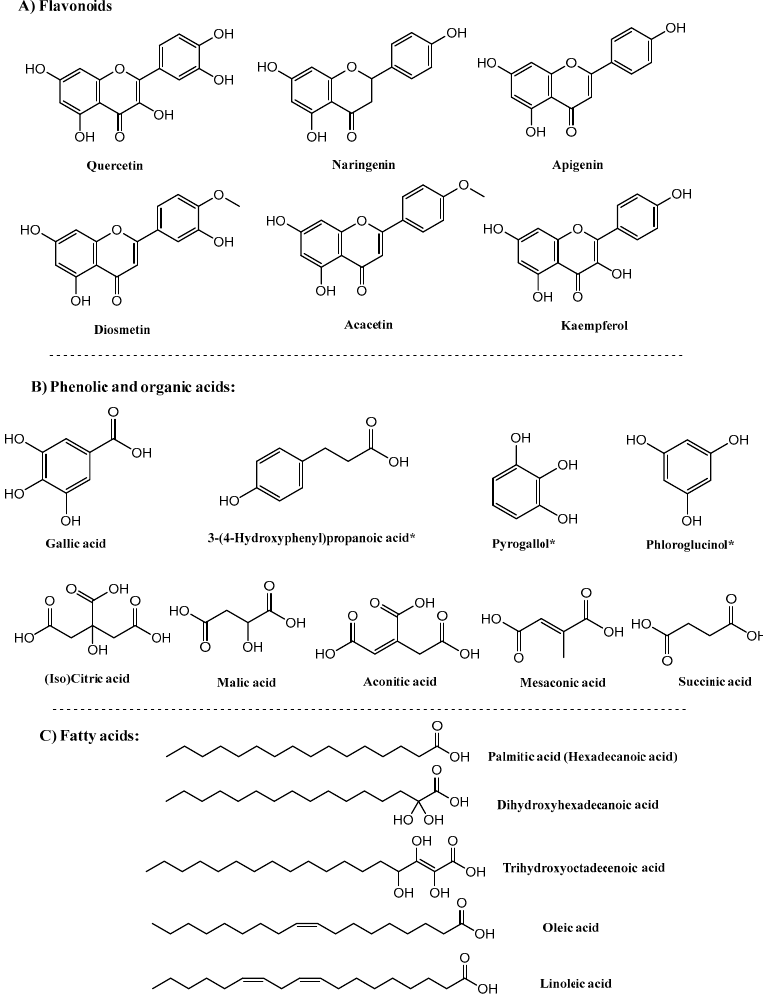
Figure 1. Chemical structures of detected metabolites from UHPLC-QTOF-MS analysis of O. ficus assayed in vitro and ex vivo with gut microbiota, * indicates biotransformed metabolites.